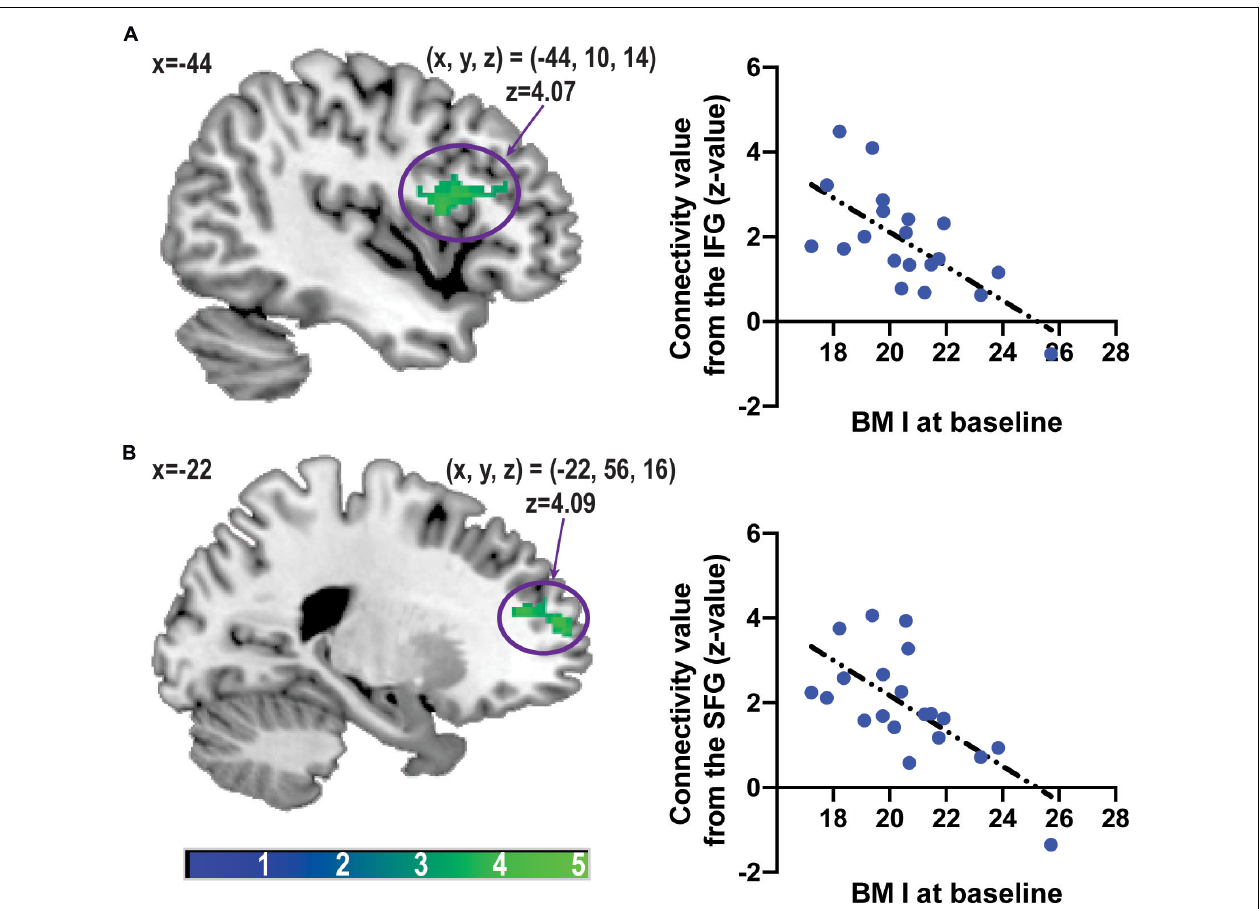
FIGURE 3 | Associations between caudate-related functional connectivity and body mass index at baseline. Scatter plots depict associations between body mass index and caudate-related functional connectivity in the inferior frontal gyrus (A) and superior frontal gyrus (B) . The color bar depicts the z -value. IFG, inferior frontal gyrus; SFG, superior frontal